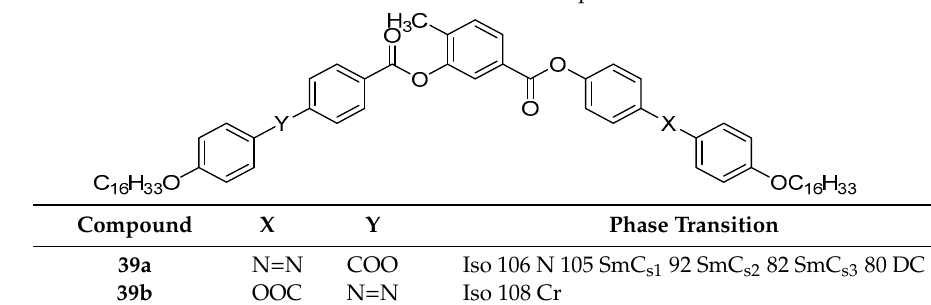
Table 7. Phase transition of compounds 39 .